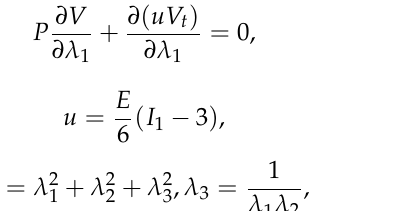
Figure 2. A cylindrical FREE actuator wrapped with a double family of helical fibers.